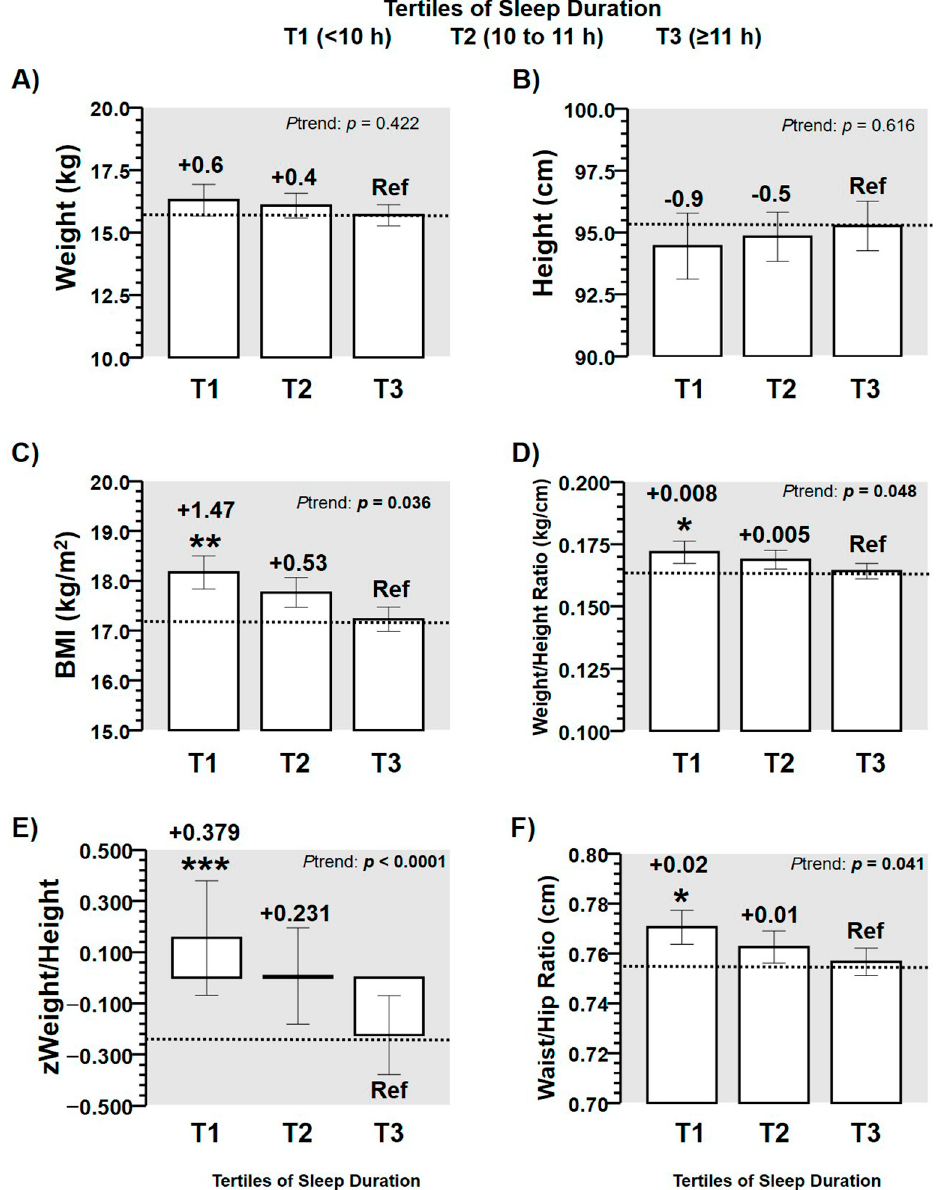
Figure 2. Characteristics of anthropometric outcomes in a sample of Chilean preschoolers ( n = 99) by tertiles of sleep duration, described as Table 1. (T1: < 10 h of sleep duration; tertile 2, T2: 10 to 11 h of sleep duration; tertile 3, T3: ≥ 11 h of sleep duration, that was used as the Reference (Ref) category). (BMI) Body mass index in kg/m 2 . Panel ( A ) describe weight, ( B ) height, ( C ) BMI, ( D ) weight/height Ratio, ( E ) z score of weight/height Ratio, and ( F ) waist/hip Ratio across tertiles of sleep duration. (*) Denotes significant differences between tertile of origin vs. tertile Reference at p < 0.05. (**) Denotes significant differences between tertile of origin vs. tertile Reference at p < 0.01. (***) Denotes significant differences between tertile of origin vs. tertile Reference at p < 0.0001.